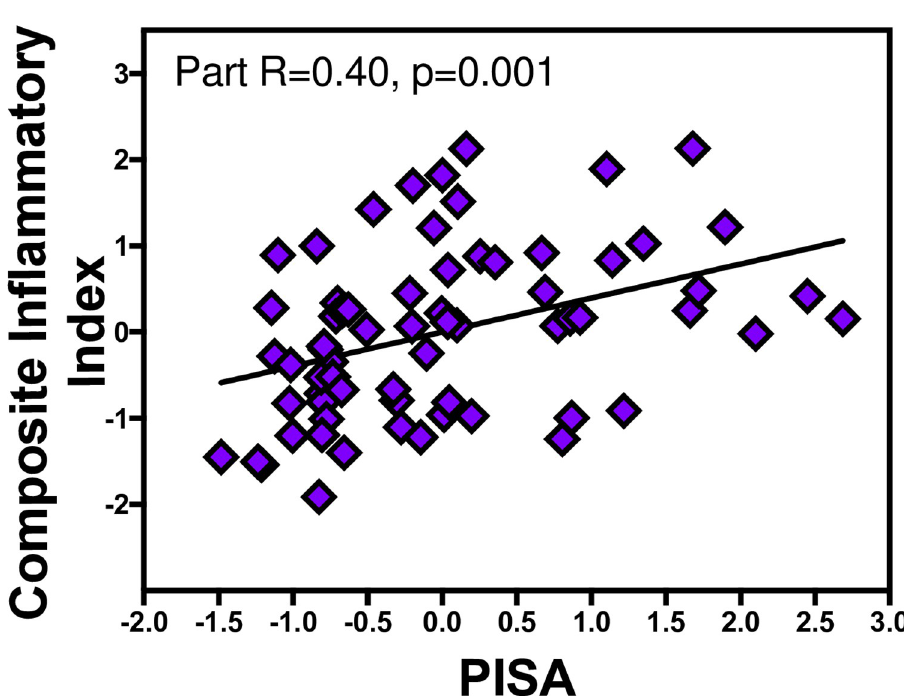
Fig 2. Partial regression plots show the relationships between PISA and salivary CII. The x and y axes are the residuals for PISA and CII adjusted for age, gender and BMI. The partial R and p values are shown.